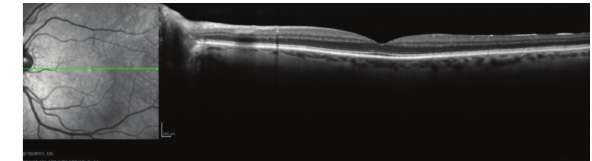
Figure1:Aspectraldomainopticalcoherencetomographylinescan of a normal eye.